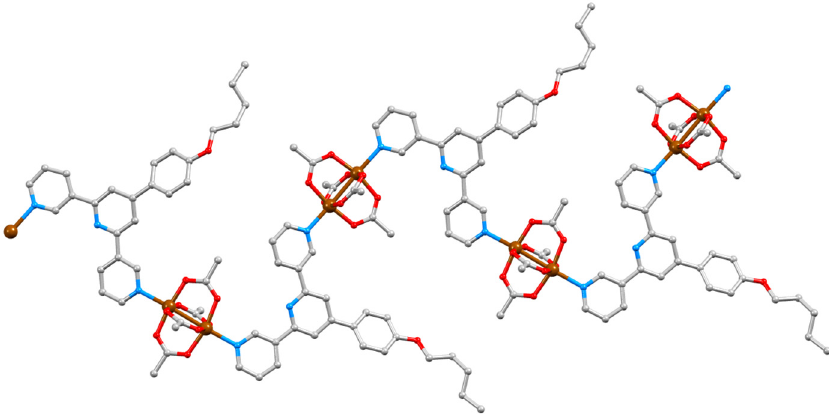
Figure 12. Part of one chain in [Cu 2 ( µ -OAc) 4 ( 3 )] n with a coordination sequence of out / in at each paddle-wheel unit; H atoms are omitted.